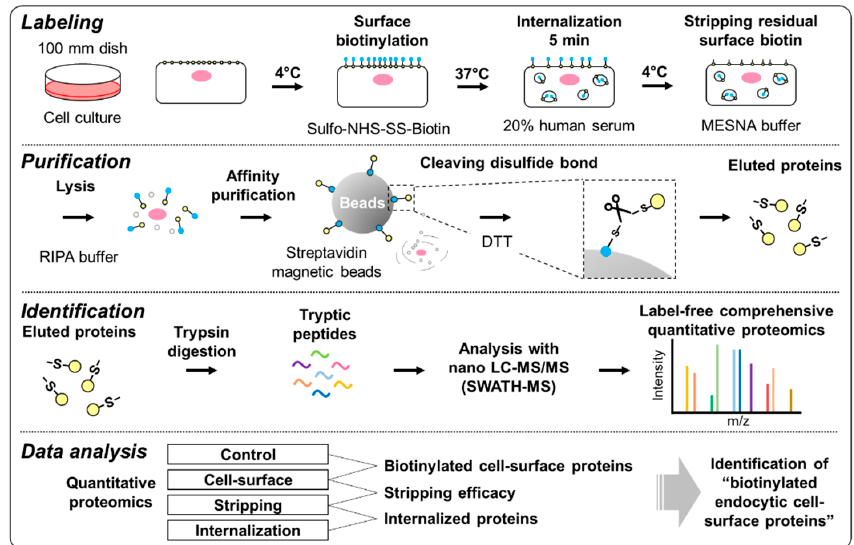
Figure 1. Experimental outline of the identification of “biotinylated endocytic cell-surface proteins” in the cells by a combination of cell-surface biotinylation methodology and SWATH-MS-based quantitative proteomics. Labeling: Cells were treated with sulfo-NHS-SS-Biotin at 4 °C for 30 min, then with 20% FBS at 37 °C for 5 min to allow protein internalization. Residual cell-surface proteins were removed by treatment with MESNA buffer. Purification: Following cell lysis with RIPA buffer, biotinylated proteins were collected using streptavidin magnetic beads. After washing the beads, the proteins were eluted from the beads by cleavage of the disulfide bonds of sulfo-NHS-SS-Biotin using DTT. Identification: The eluted proteins from streptavidin magnetic beads were digested with trypsin, then tryptic peptides were analyzed via SWATH-MS-based quantitative proteomics. Data analysis: Selection of “biotinylated cell-surface proteins” and “biotinylated endocytic cell-surface proteins” was performed as described in Section 3.2.